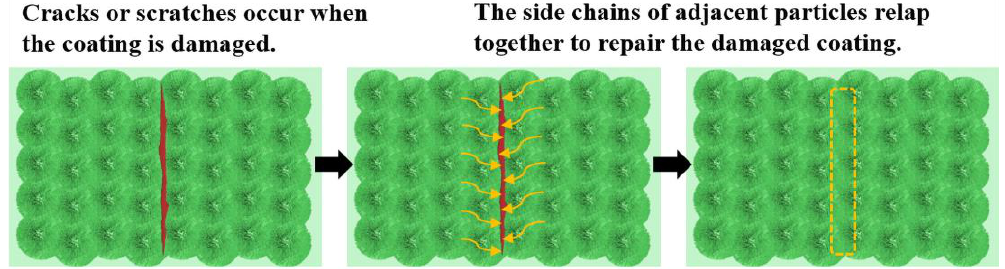
Figure 7. Self-repairing mechanism of the modified nanoscale titania coating.